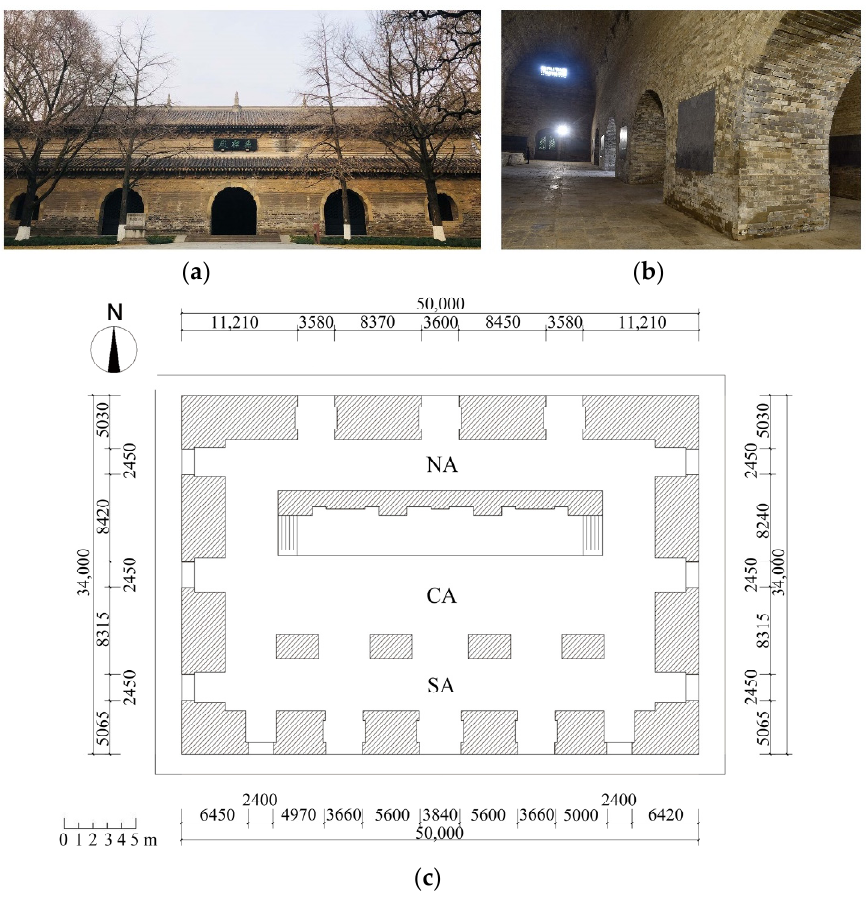
Figure 1. Beamless Hall at Linggu Temple: ( a ) exterior view, ( b ) interior view, and ( c ) floor plan.